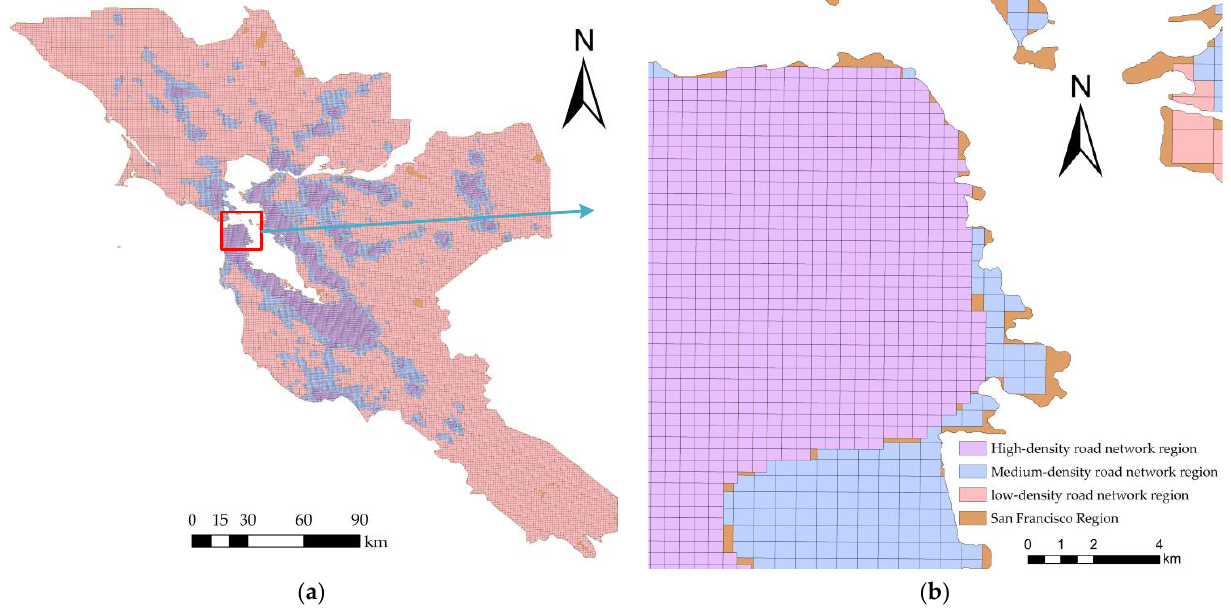
Figure 6. Grid division results: ( a ) Grid division; ( b ) Extraction example.